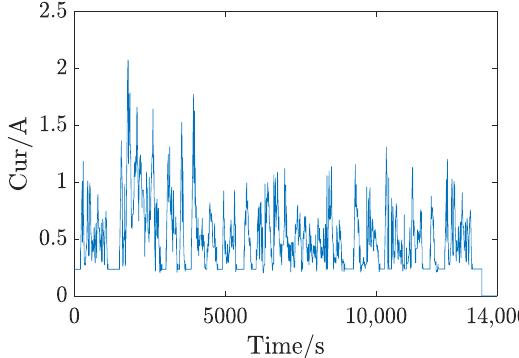
Figure 4. The current waveform under UDDS test.